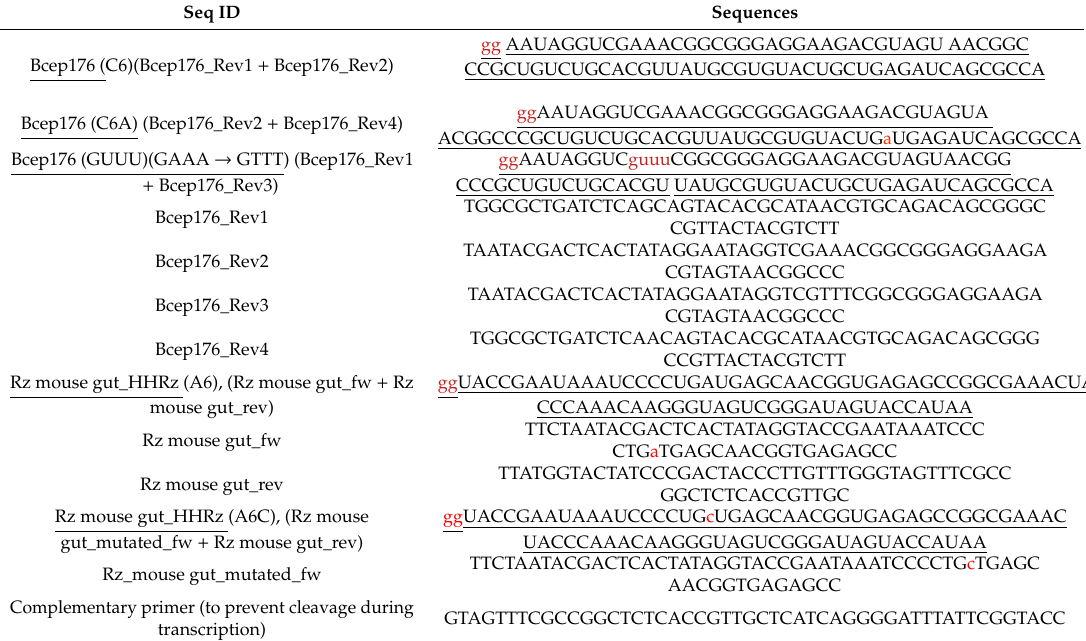
Table 2. Wild-type and mutant sequences for Bcep176 and mouse gut HHRz and the primer sequences